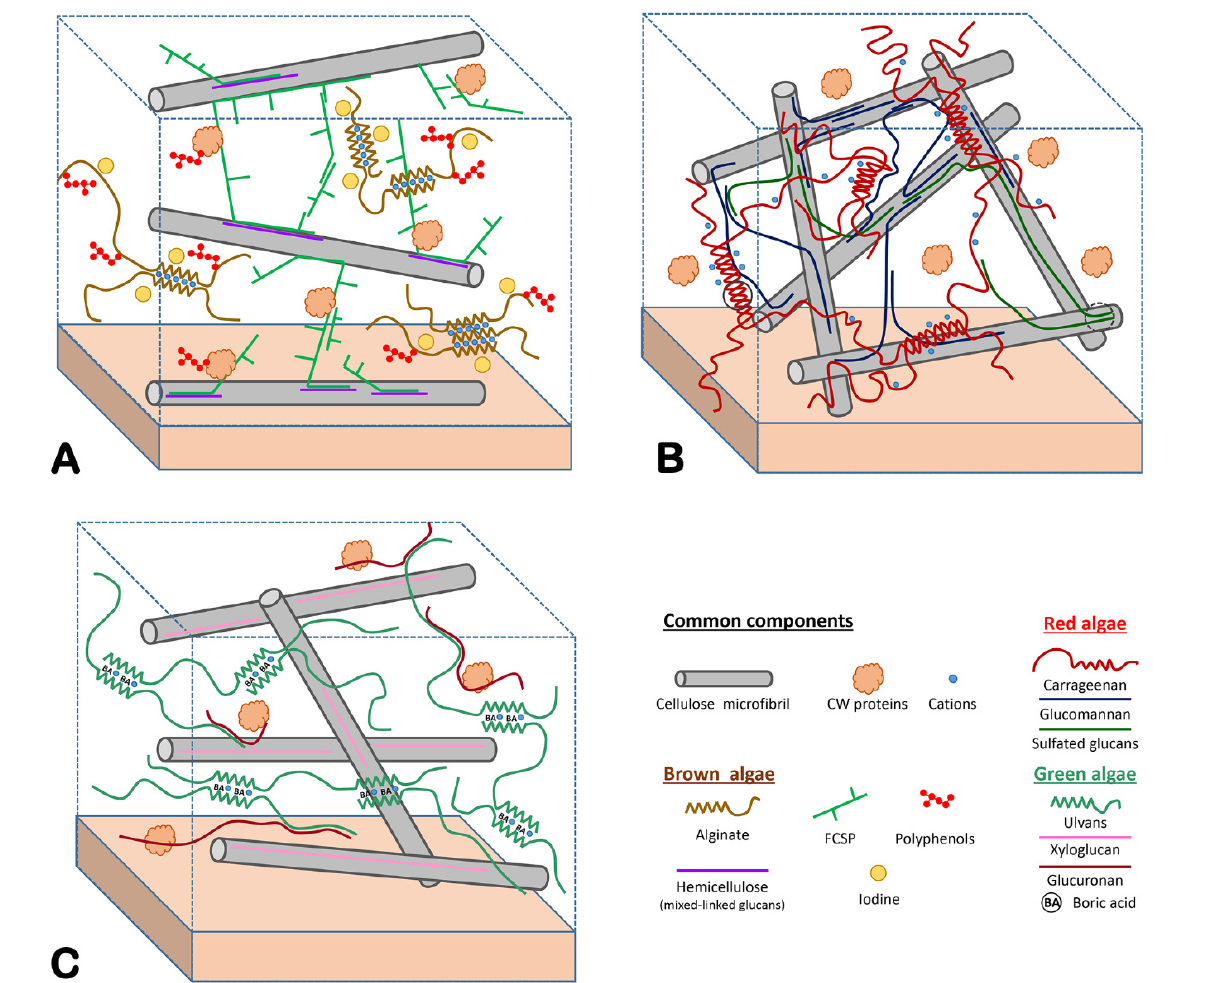
Figure 2. Models of macroalgal extracellular matrices. Semicrystalline cellulose microfibrils are present in almost all types of macroalgae. They constitute a crucial structural component but are sparse in comparison to plant cell walls. Most cell wall structural proteins have yet to be characterized, but their identity is expected to differ in each macroalgal phylum. ( A ) Brown algae (example of a Fucales species). Alginates are the most abundant component of brown algal ECMs. Alginate chains auto-associate through their guluronate (G)-rich regions. This process is coordinated by Ca 2+ ions. Fucose-containing sulfated polysaccharides (FCSPs) acts as cross-linkers between cellulose microfibrils. Hemicelluloses ( β -1,4-1,3-glucans, β -1,3-glucans) have been recently identified in brown algae and might act as intermediates between the cellulose microfibrils. Phlorotannins (polyphenols) are likely to be associated with alginates and proteins. Iodine is generally abundant in brown algal ECM but its association mode with other components is unresolved. Arabinogalactan proteins and proteins containing WSC-domains have been identified among CW proteins. Model adapted from Deniaud and coworkers [26] and updated based on the following references [27–29]. ( B ) Red algae (example of a carrageenophyte). Sulfated galactans (carrageenans in this case) are the most abundant polymers of the red algal ECM. Chains containing 3,6-anhydro-D-galactose units associate through hydrogen-bonding and hydrophobic interactions. The resulting helices further cluster into microfibrils by ionic interactions between their sulfate groups and cations. Glucomannans have been shown to cross-link cellulose microfibrils. Sulfated glucans have been identified as a minor component, but their interactions with the other polysaccharides remain uncertain. Model adapted from the following references [32–34]. ( C ) Green algae ( Ulva species). The major polysaccharide ulvan can form a weak gel in the presence of both boric acid and divalent cations (e.g., Ca 2+ ). However, the exact mechanism of chain association is currently not understood. Two minor polysaccharides were also identified. Xyloglucans interact with cellulose, but their role as cross-linkers of cellulose microfibrils remains to be demonstrated. In contrast, glucuronans interact with ulvans and proteins. Model adapted from Lahaye and Robic [35]. The large majority of red macroalgae produce sulfated galactans, agars or carragee- nans, which are the main components of their ECM (Figure 2B) [36]. These polysaccha-